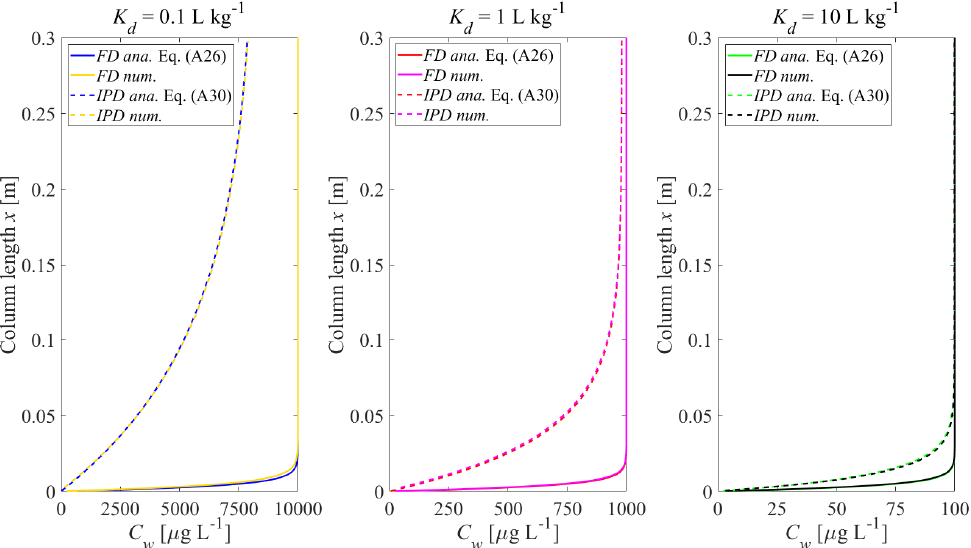
Figure A2. Concentration increase in a water parcel ( C w , peak ) in the column during the first flooding (up-flow); solid lines: film diffusion; dashed lines: intraparticle diffusion; comparison between analytical (ana.) and numerical (num.) solutions. n = 0.45, v = 1.67 × 10 − 5 m s − 1 , α / x = 0 (no dispersion), C s , ini = 1000 µ g kg − 1 , t = 5 h, D aq = 1 × 10 − 9 m 2 s − 1 , ε = 0.05, d p , coarse = 2000 µ